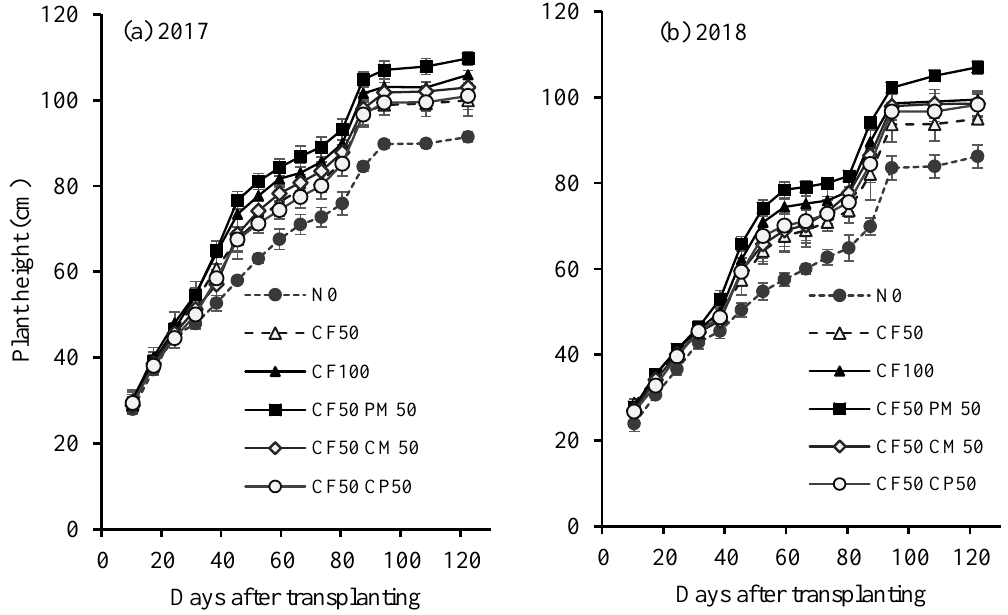
Figure 1. Plant height (cm) of rice variety Manawthukha affected by organic fertilizers. The numbers followed by treatment show the amount of N applied as a percentage based on 85 kg N (or estimated mineralizable nitrogen; EMN) ha −1 . CF = chemical fertilizer, PM = poultry manure, CM = cow manure, CP = compost. Vertical bars represent the SD of three samples.